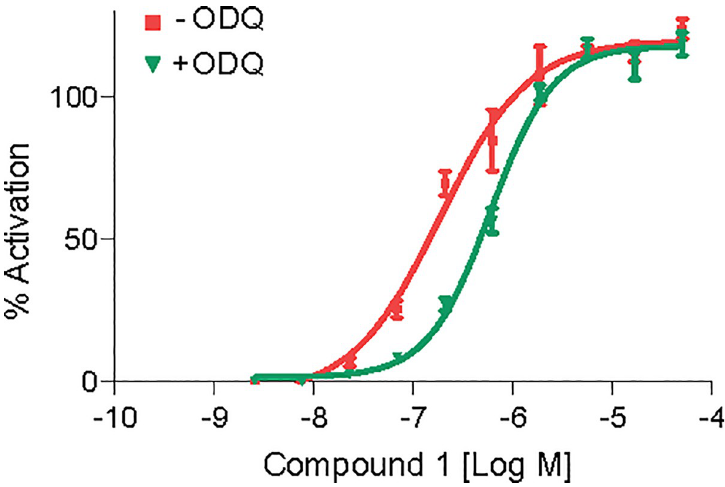
Fig 1. In vitro activity of compound 1 in CHO-K1/sGC stable cell line. The in vitro activity of compound 1 was assessed in cell-based sGC Functional Assay (CASA Assay) using CHO-K1/sGC stable cell line. Red square denotes compound 1 sGC activation in absence of ODQ and the green triangle shows activation in presence of ODQ.